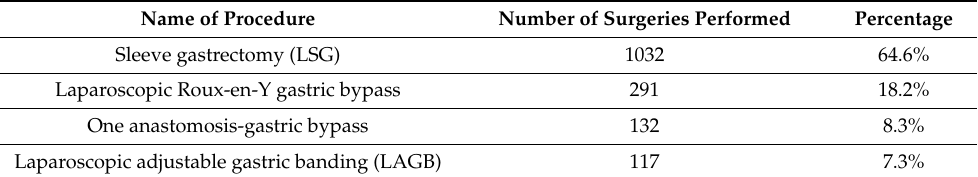
Table 2. Bariatric procedures performed in Poland in